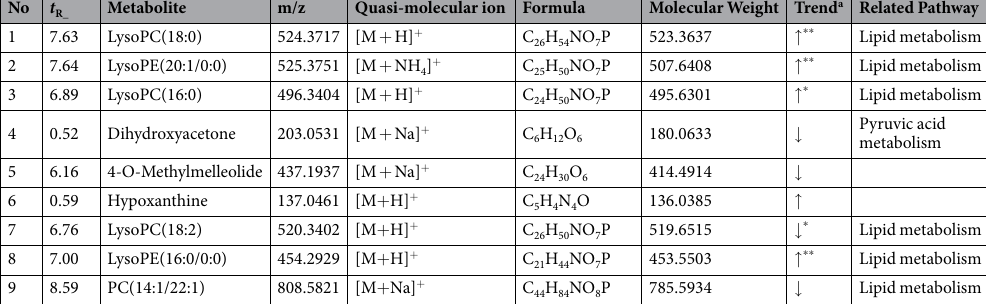
important organs and the right heart of AS 16 . AS broilers are often in a subclinical state because of the presence of